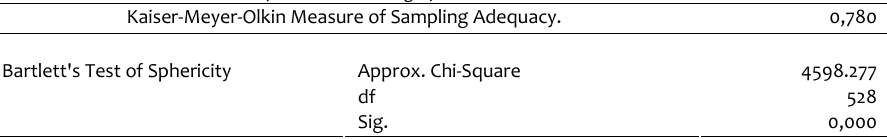
Table 1: КМО and Bartlett’s test of the statistical significance Kaiser-Meyer-Olkin Measure of Sampling